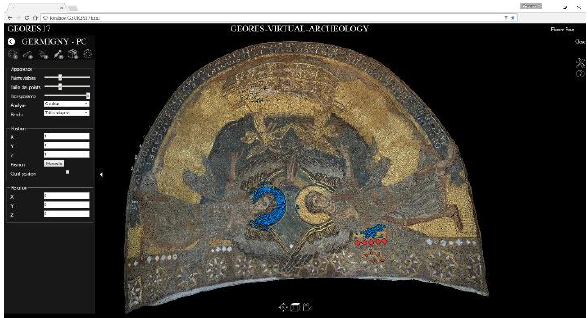
Figure 12 First GUI iteration of the web-based platform for point cloud dissemination and 3D viewpoint management